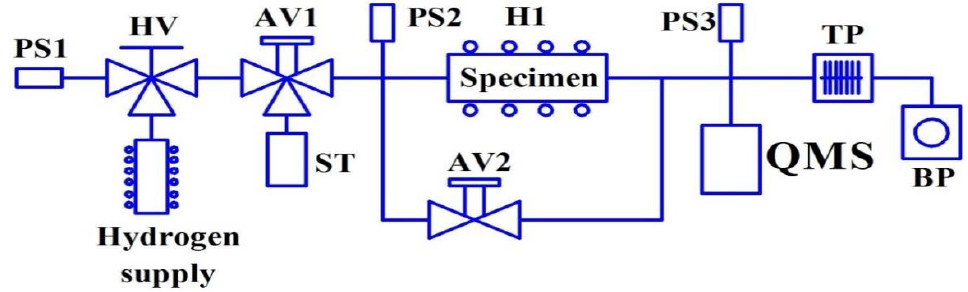
Figure 3. Permeability testing system: PS1, PS2, PS3—pressure sensors; HV—hand valve; AV1,